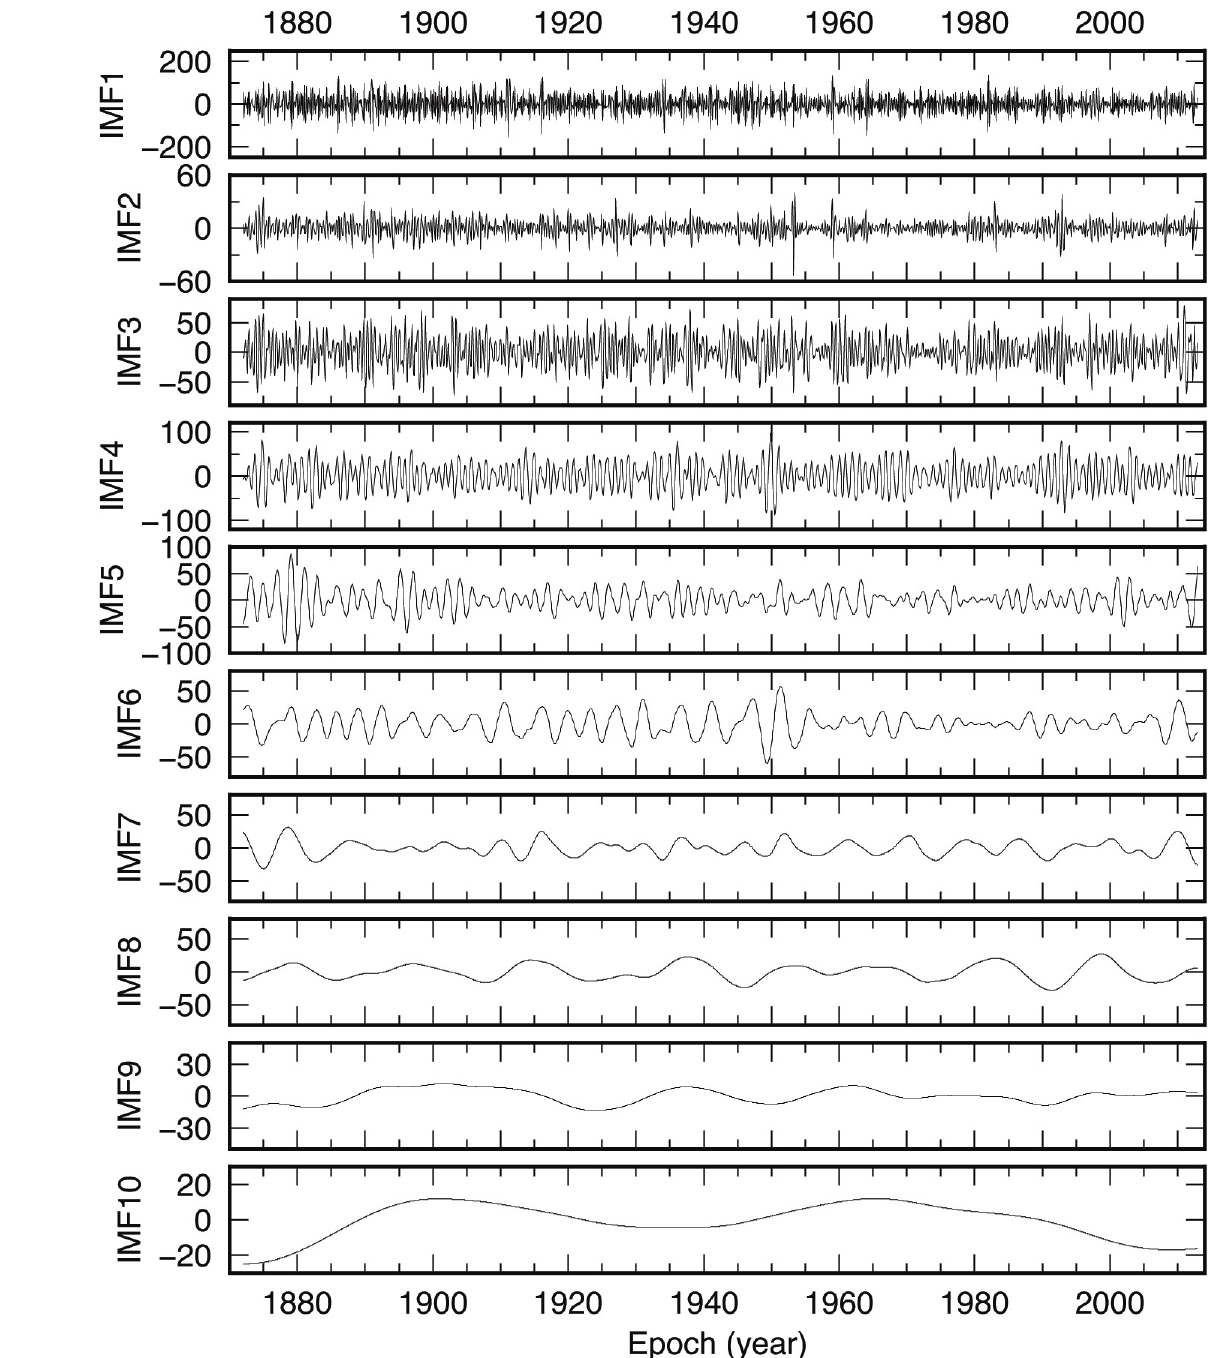
Figure 7. Image functions IMFk ( k =1,..,10) resulting from the EEMD analysis of the AS curve shown in Figure 2. Note the different scales on the